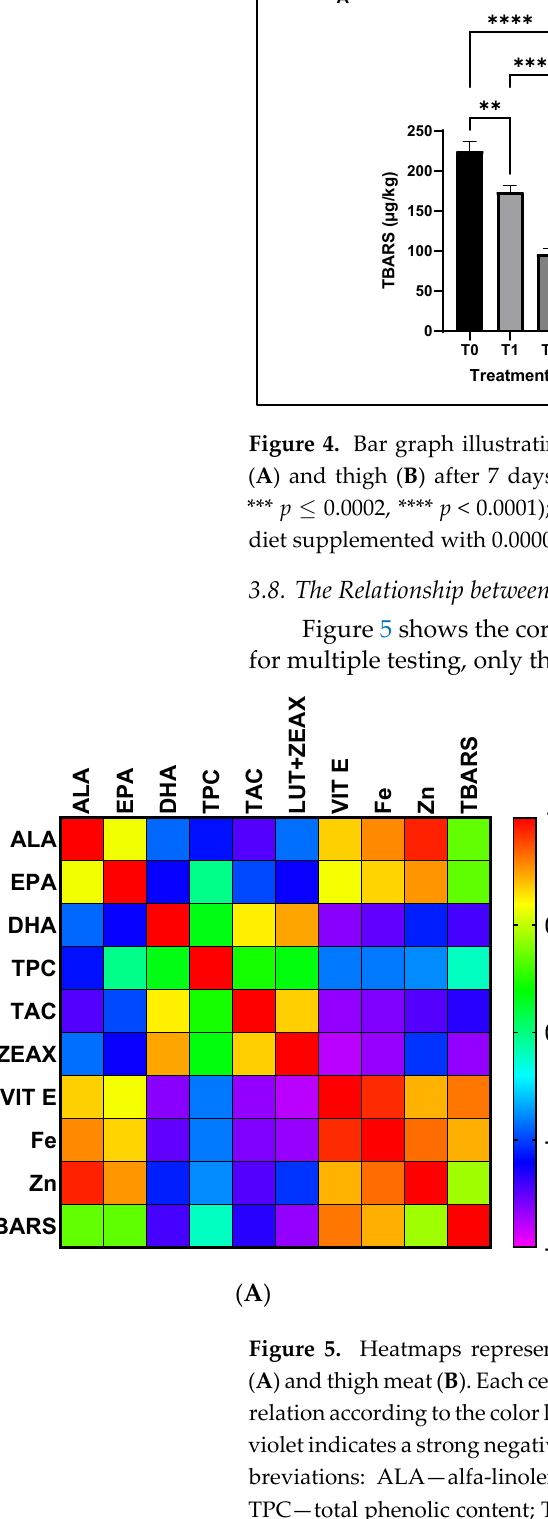
12 of 22 Figure 3. Bar graph illustrating total antioxidant capacity (TAC) as µg Trolox of chicken breast ( A ) and thigh ( B ). Asterisks denote statistical significance ( p > 0.1234 ns, * p ≤ 0.0332, ** p ≤ 0.0021 ); T0: control diet; T1: treatment with 0.00002% Cr; T2: experimental diet supplemented with 0.00002% Cr +2% sea buckthorn leaves (SBL); ns = non-significant. The breast samples from T2 and T1 showed a higher antioxidant capacity compared